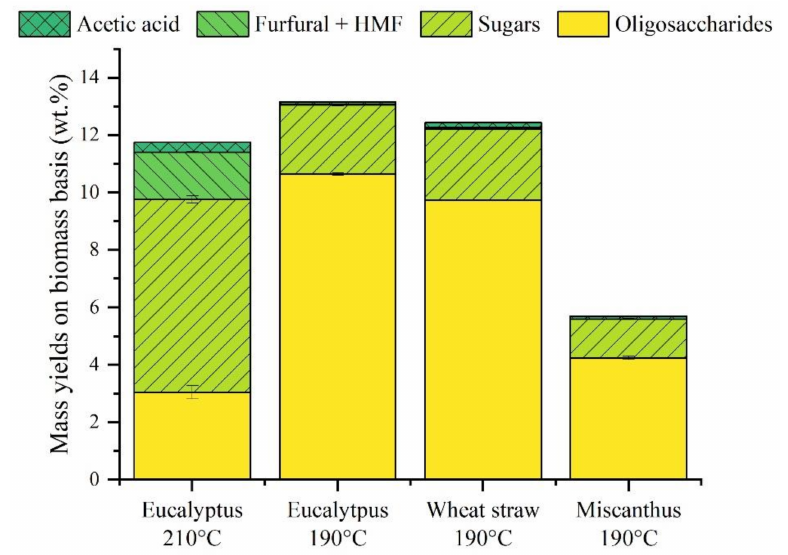
Figure 1. Oligosaccharides and monomers yields of autohydrolysis reaction on the basis of total